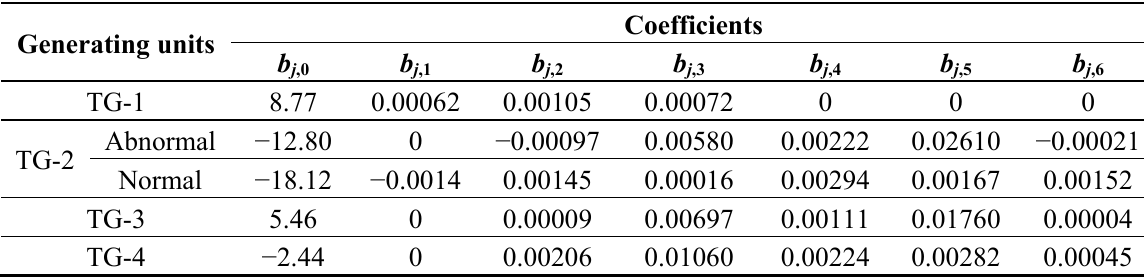
Table 3. Coefficients of steam turbines’